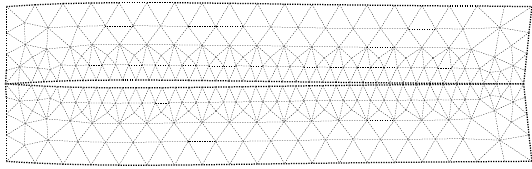
Figure 6.3 . Deformed configuration of the two viscoelastic bodies for µ = 0 . 5ns/m 2 and η = 0 . 3ns/m 2 .